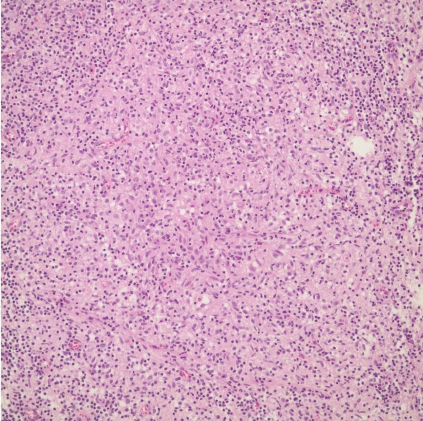
Figure 4: H&E, 200x. The lymphohistiocytic reaction and abortive granuloma